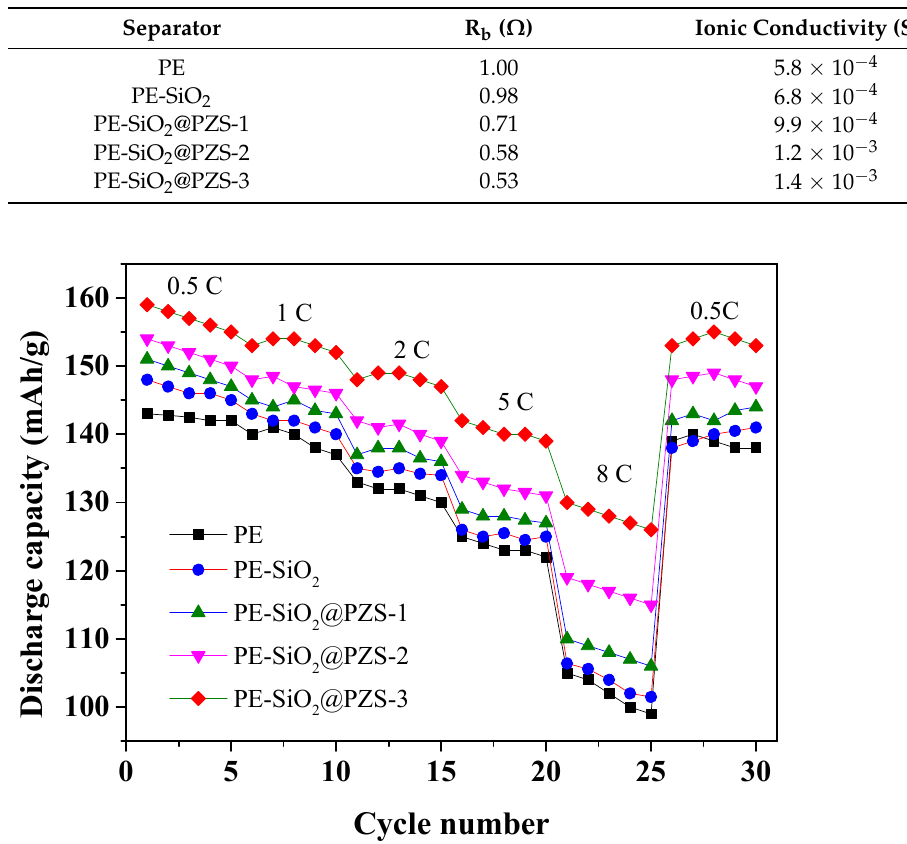
Figure 5. Discharge capacities of the cells assembled with the PE membrane, PE-SiO 2 , PE-SiO 2 @PZS-1, PE-SiO 2 @PZS-2 and PE-SiO 2 @PZS-3 separators at different discharge rates.